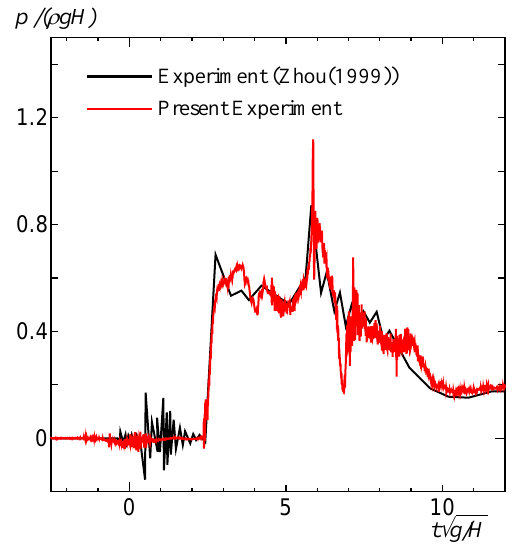
Fig. 5. Comparison with time history of pressure